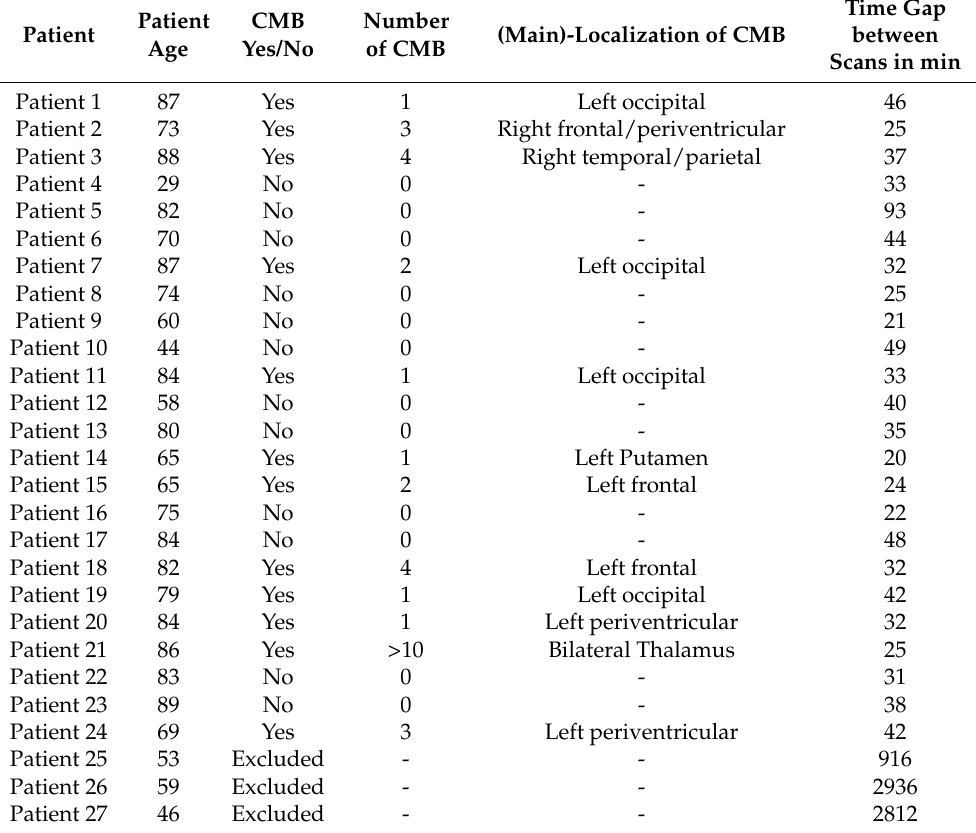
Table 2. Detailed patient